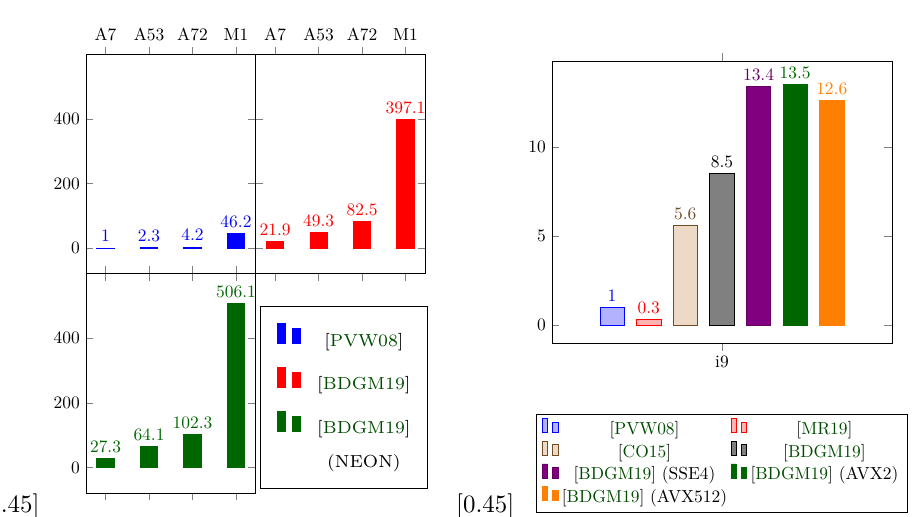
Figure 4: Speedup, for the x86 device, for the proposed implementation of [BDGM19], and SotA [PVW08, MR19, CO15]. The result for [PVW08] is used as the